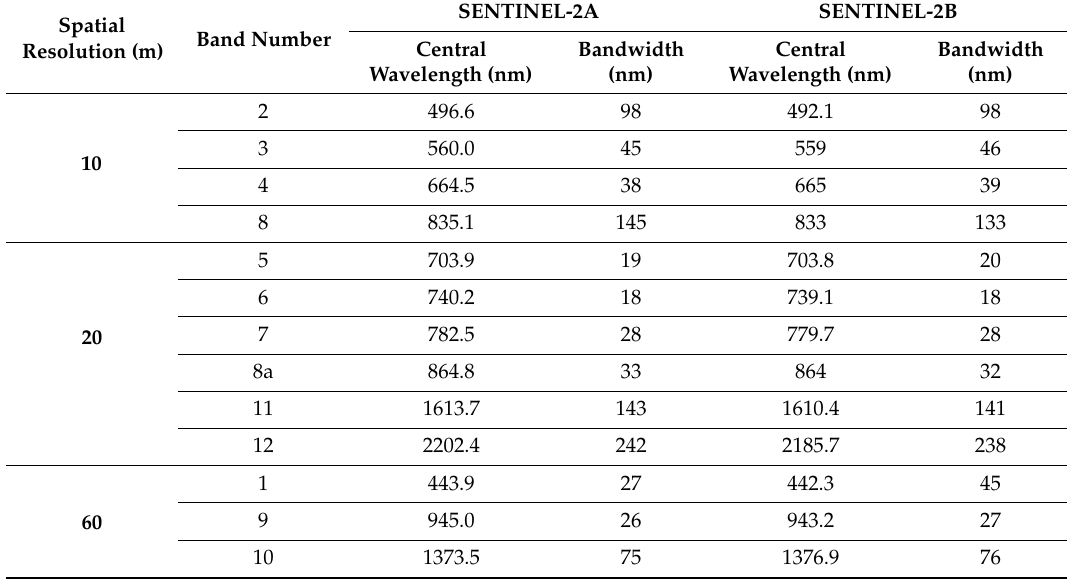
Table 4. Technical characteristics of the moderate spatial resolution (MSR) multi-spectral SENTINEL-2 sensor and images used for this